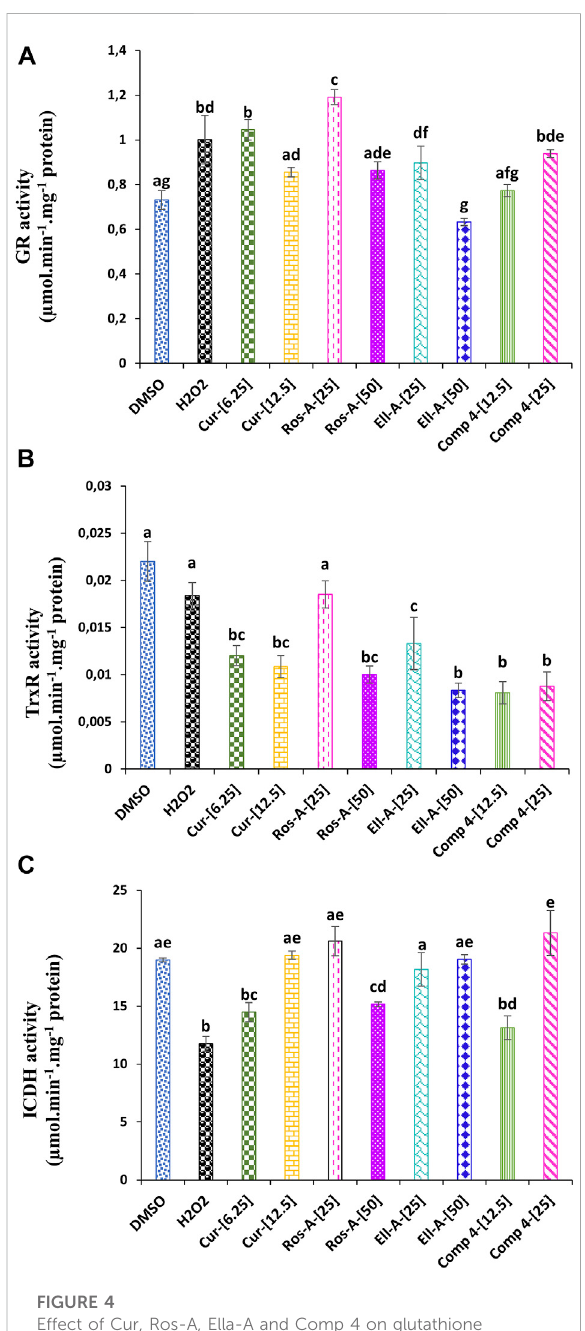
FIGURE 4 Effect of Cur, Ros-A, Ella-A and Comp 4 on glutathione reductase (GR). (A) Thioredoxin reductase (TrxR). (B) and isocitrate dehydrogenase (ICDH). (C) activities in THP-1 cells treated with H 2 O 2 .Eachvaluerepresentsthemeanofthreereplicate.Bars represent standard error. Different letters indicate signi fi cant differences among treatment at p <